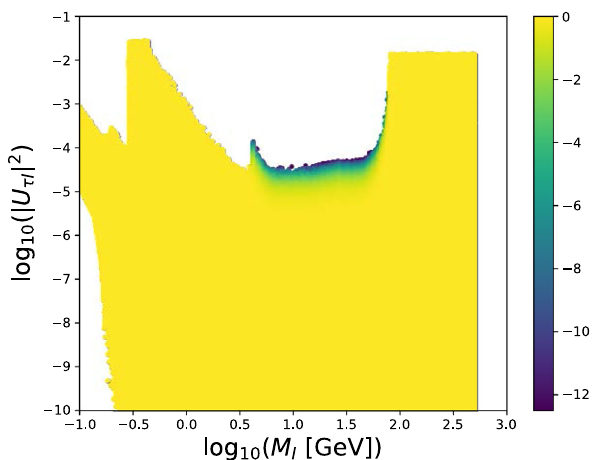
Fig. 37 Partial likelihood from the long-lived particle searches with DELPHI, in the M I − | U τ I | 2 plane